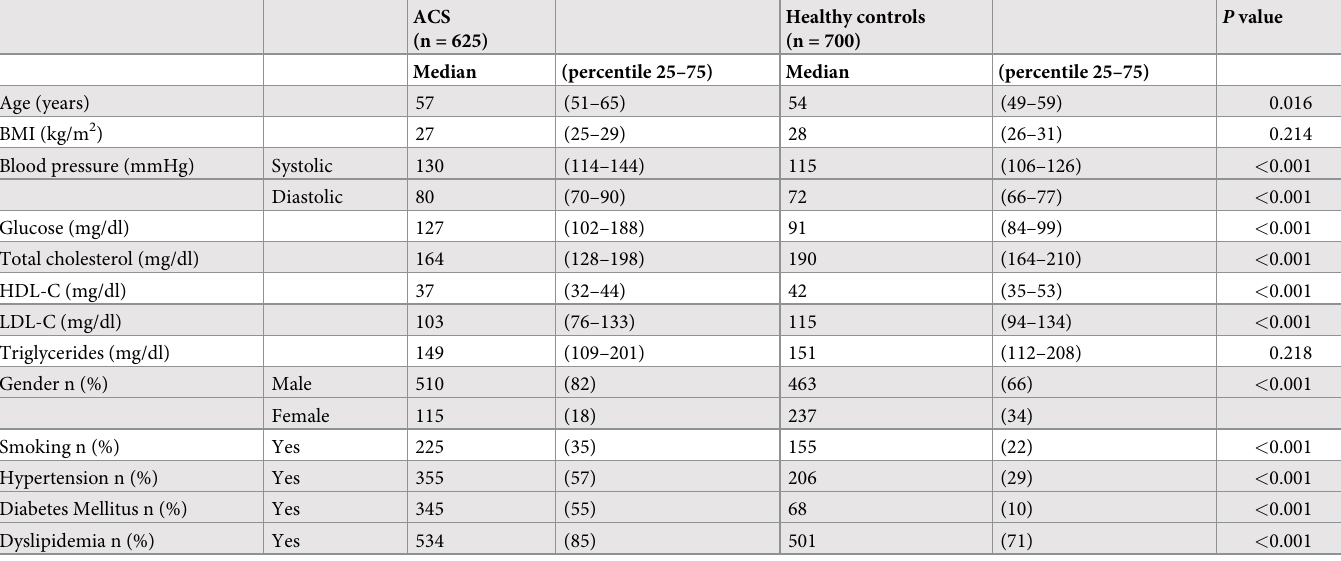
Table 1. Demographic characteristics and biochemical parameters of the study individuals.